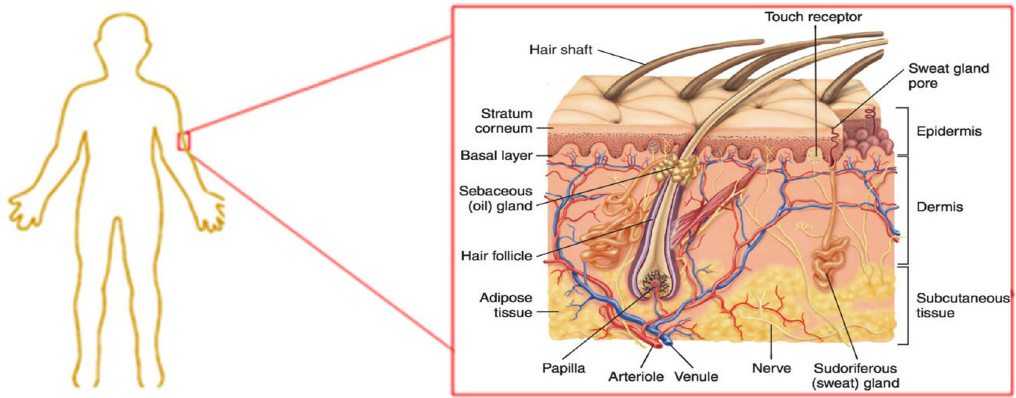
Figure 1: Structure of human skin. The skin layers include epidermis, dermis, and hypodermis ( subcutaneous tissue ) . Reproduced with permission from Yan et al. [ 1 ]